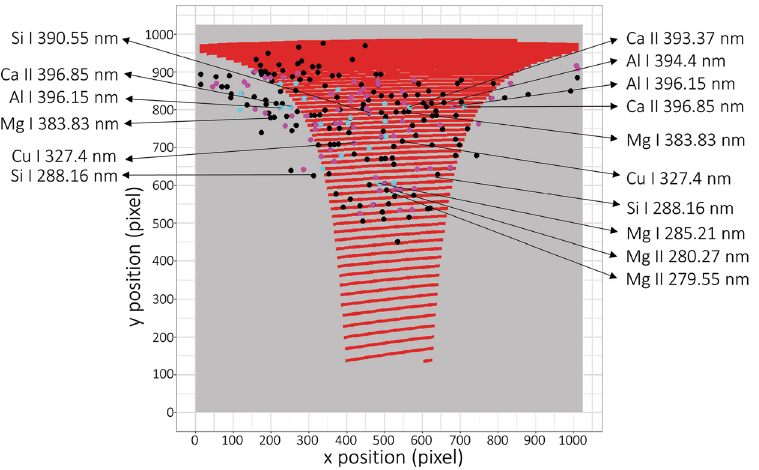
Figure 3. Diffraction orders of the echelle spectrometer used for the readout of a typical LIBS spectrum (red lines) and positions selected based on the proposed approach (225 pixels - black dots, 86 pixels – pink dots, 21 pixels – cyan dots).